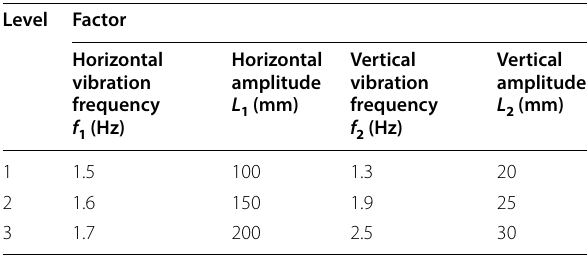
Table 1 Automated material tidying orthogonal test factors and levels Level Factor